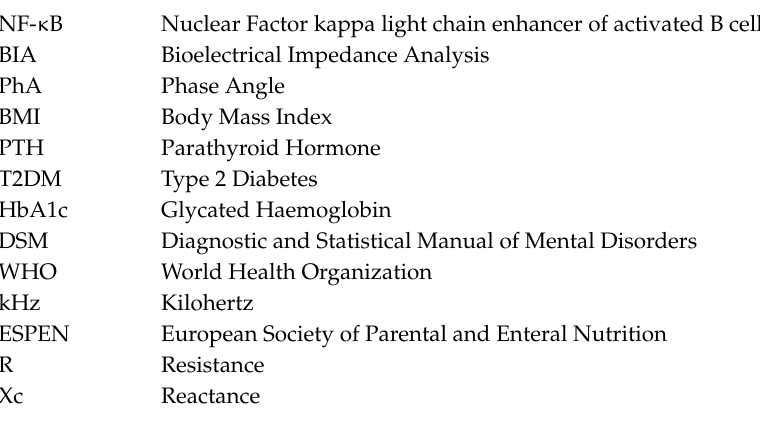
s1, Table S1: The demographics information, including age, smoking habits, and physical activity for the di ff erent obesity categories, in study population. Figure S1: The di ff erence of phase angle across all body mass index